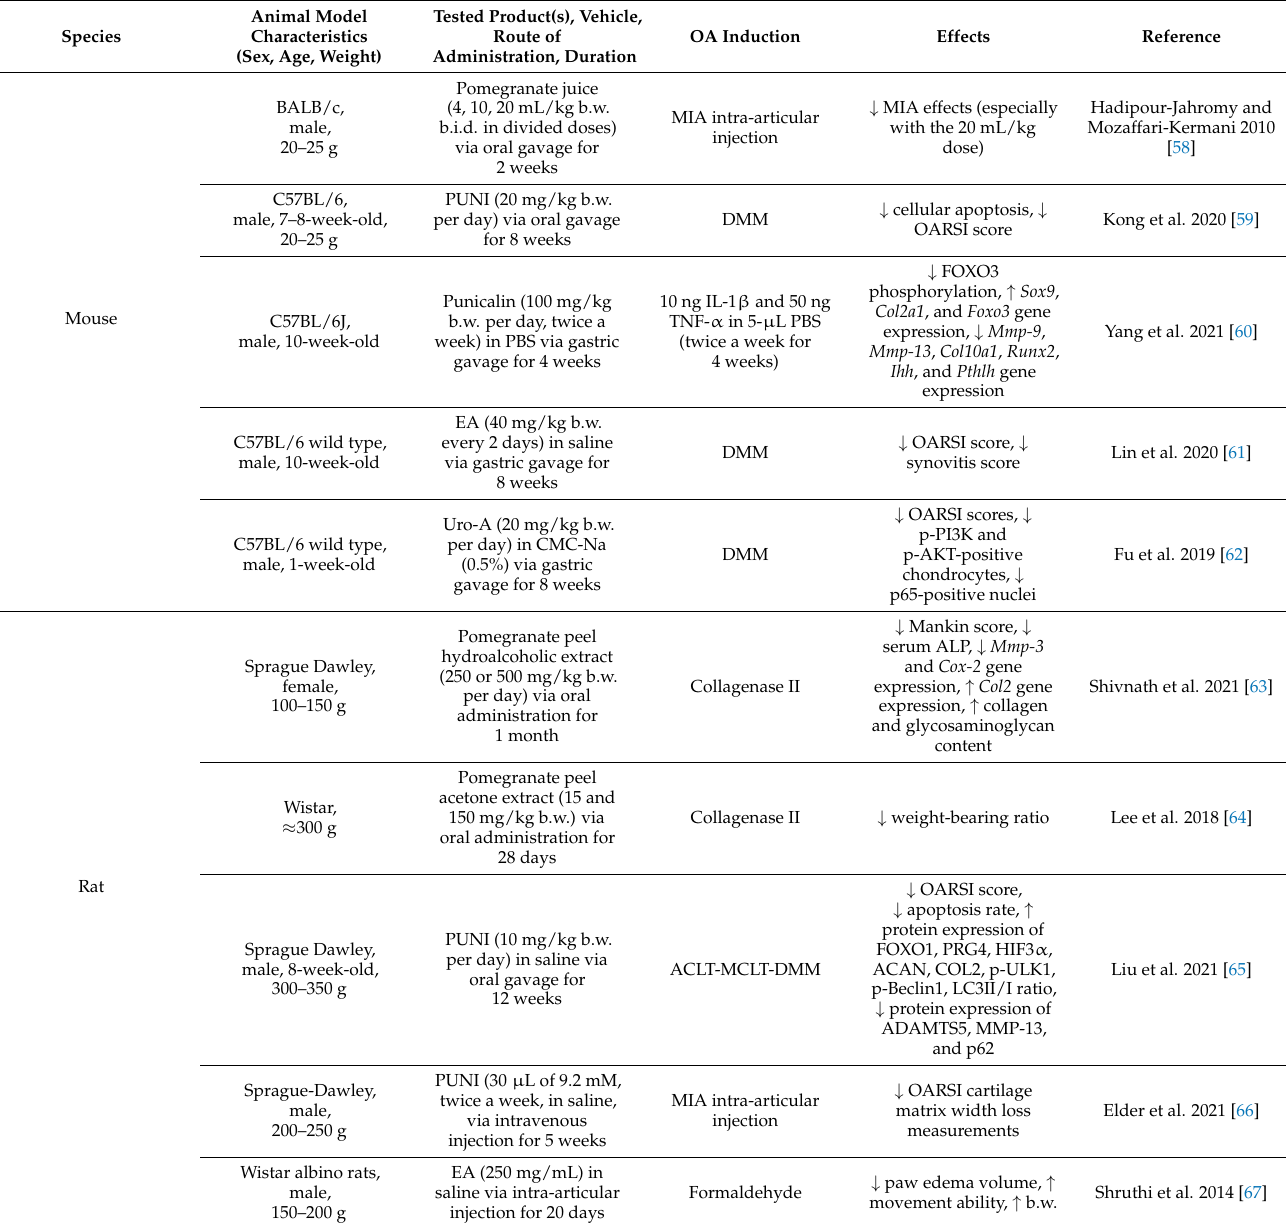
Table 3. Overview of the effects of HT-containing products in OA animal models (see Table S1 for specific details on sample preparation and bioactive compound content in the tested